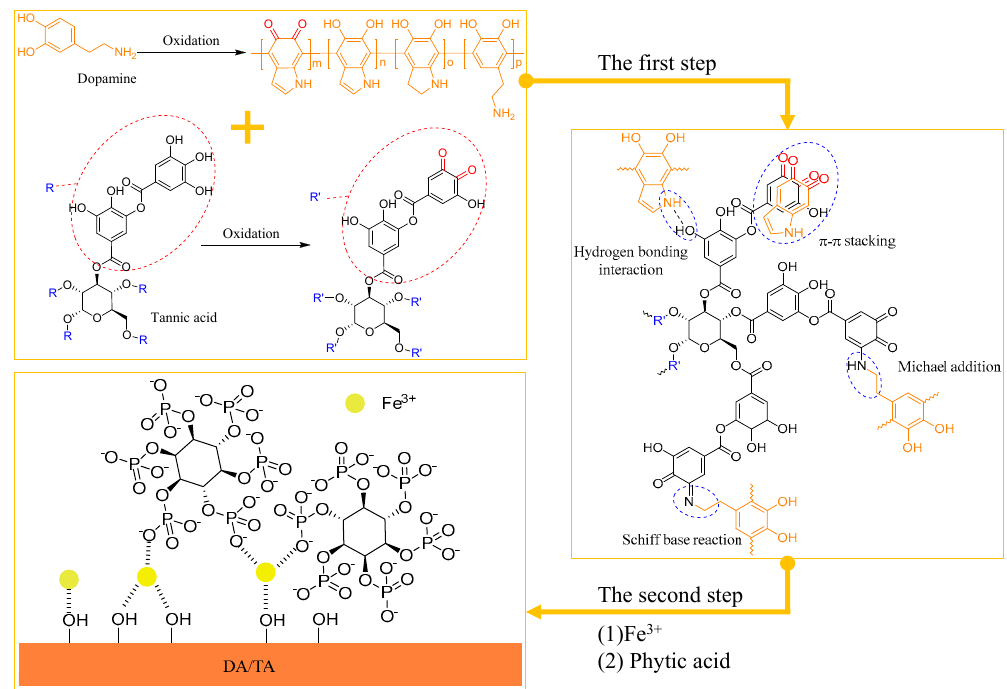
Scheme 2. The formation mechanism of a DA/TA-PhA membrane.